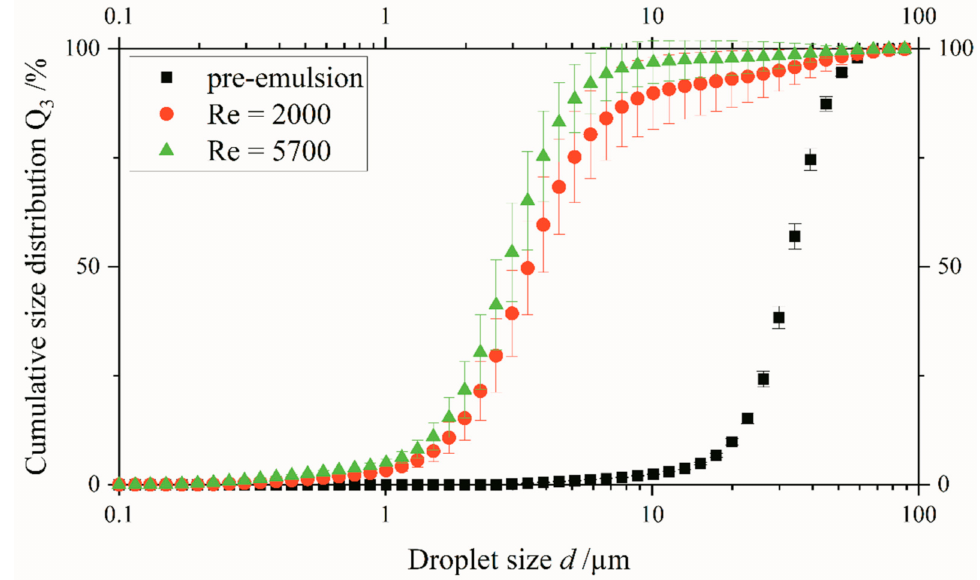
Figure 26. Droplet size distribution of the pre-emulsion and the processed emulsions processed on the original